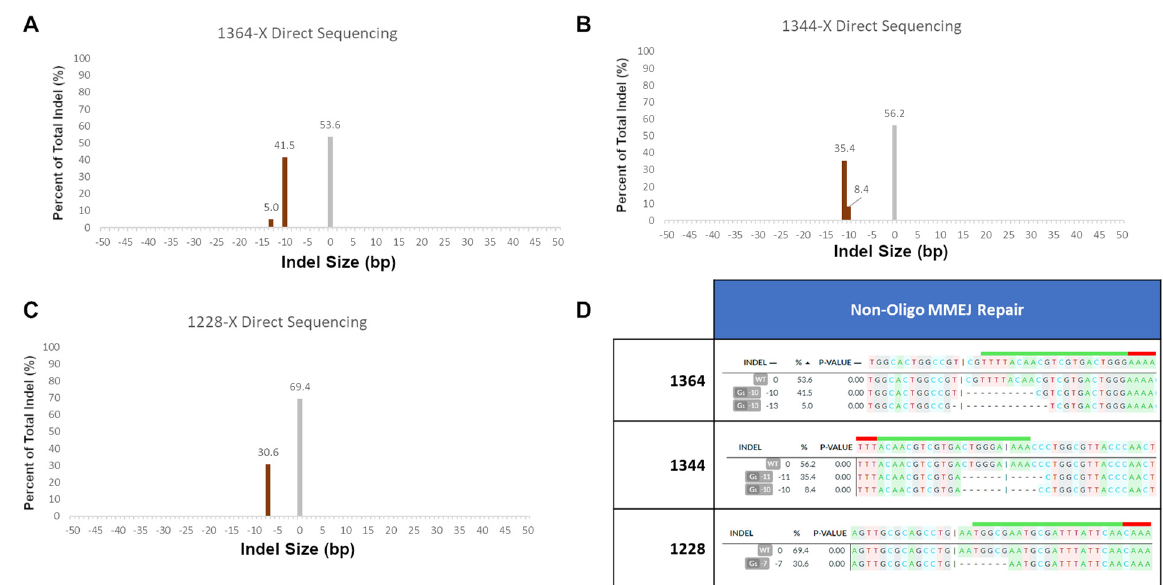
Figure 4. Non-Exact repair outcomes in reactions containing no repair ssODN. Gene repair reactions were performed using the in vitro system in the absence of and ssODN repair template, to determine whether or not the secondary products seen in Figure 3 were influenced by the presence of a repair template. Unedited sequences are displayed in gray and edited sequences are shown in dark orange. ( A ) Indel products seen when targeting the 1364 LacZ site. ( B ) Indel products seen when targeting the 1344 LacZ site. ( C ) Indel products seen when targeting the 1228 LacZ site. ( D ) Specific resultant repair outcomes seen in the three non-ssODN reactions, deconvoluted and aligned using DECODR [61]. The alignment of the gRNA is shown as a green bar at the top of the reference sequence (with a red end for the PAM site), and the specific cut site on the S-strand of the DNA is shown as a pipe (|). Deleted bases are represented by dashes.